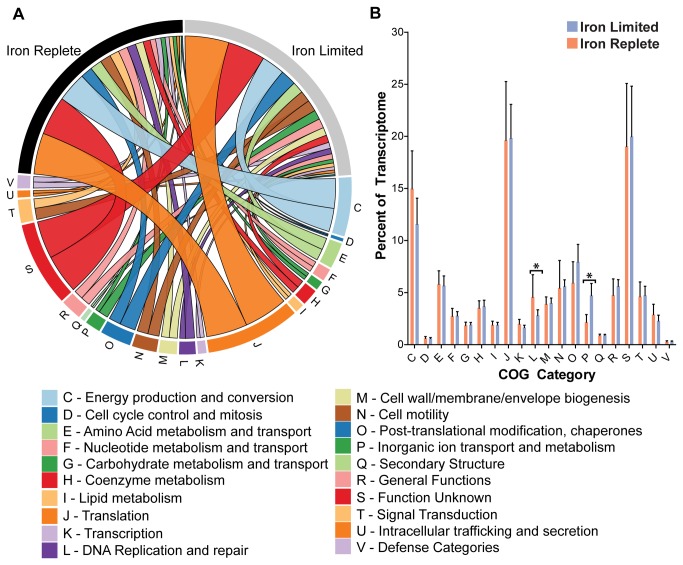
The overall transcriptome of C. jejuni is relatively unchanged under iron limitation.The absolute abundance of each gene in the C. jejuni genome was calculated and used to determine its contribution to the total transcriptome. These contributions were summed and grouped by COG category to determine the overall contribution of each COG category to the C. jejuni transcriptome under each condition (Panel A). The only statistically significant differences are enrichment for the COG category for inorganic ion transport and metabolism under iron limited conditions and enrichment for DNA replication and repair under iron replete conditions (Panel B) (* p<0.05). Figure made using Circos v0.54.